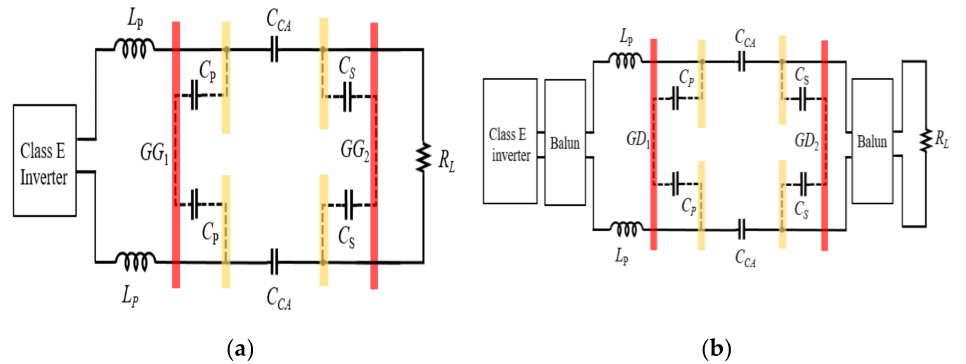
Figure 16. S-CPT system topology ( a ) without a balun and ( b ) with a